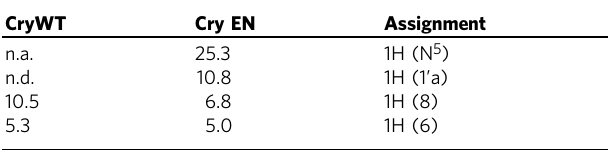
Table 1 Q-band ENDOR hyper fi ne values and their assignments for dCRY WT and the L405E/C416N (EN) variant.